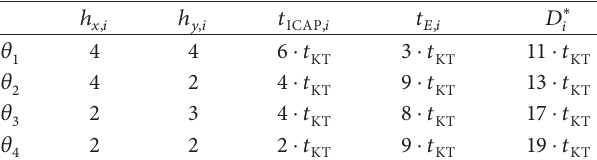
Table 1: Task-set used in Figure